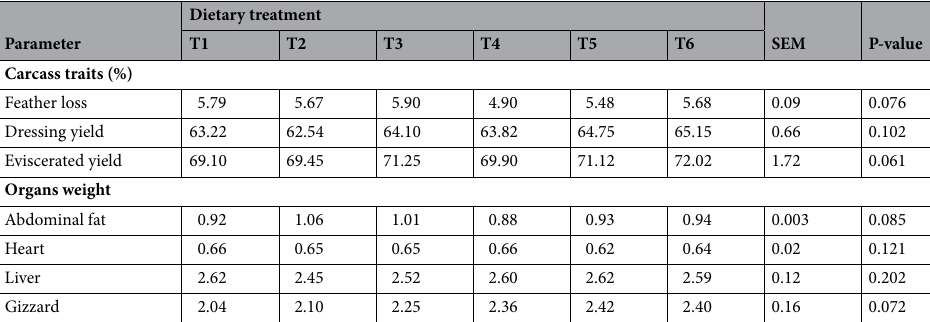
Table 4. Effect of dietary para-probiotic on carcass traits and organ weight (% of live weight) in broiler chickens. Mean values bearing the same superscript in a row did not differ significantly (P < 0.05). T 1 = control,